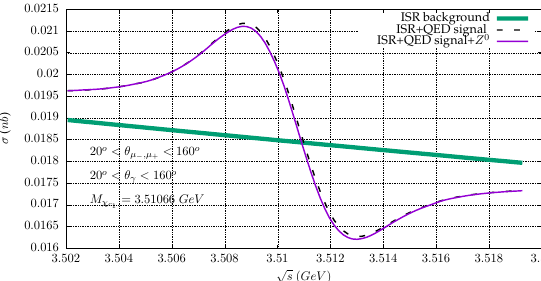
Figure 3. The cross section e + e −